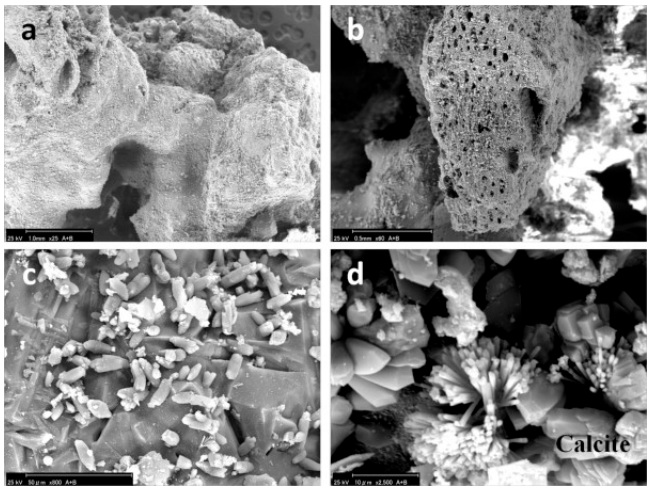
Figure 3. SEM images of bottom ash. ( a , b ) shows the irregularly-shaped bottom ash particles, which are porous in nature; ( c ) shows crystallized anhydrite or gypsum on the surface of bottom ash particles; ( d ) shows rhombohedrally-shaped calcite crystals and other calcium-based minerals [35].